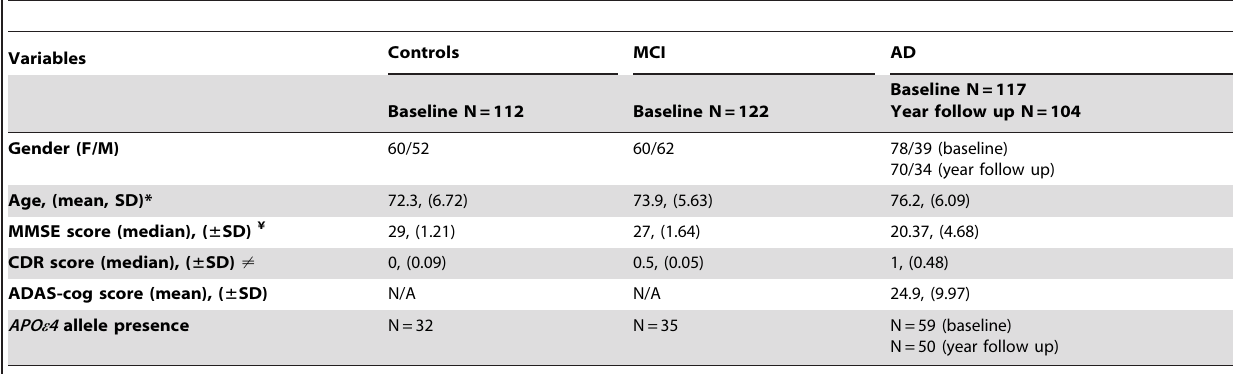
Table 1. Demographic and clinical parameters of AD patients, MCI and control subjects.